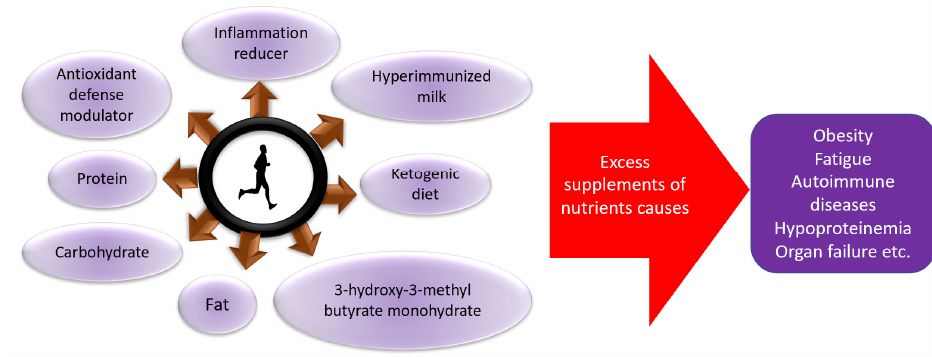
Figure 3. Role of nutrients for increased or decreased exercise performance and health .